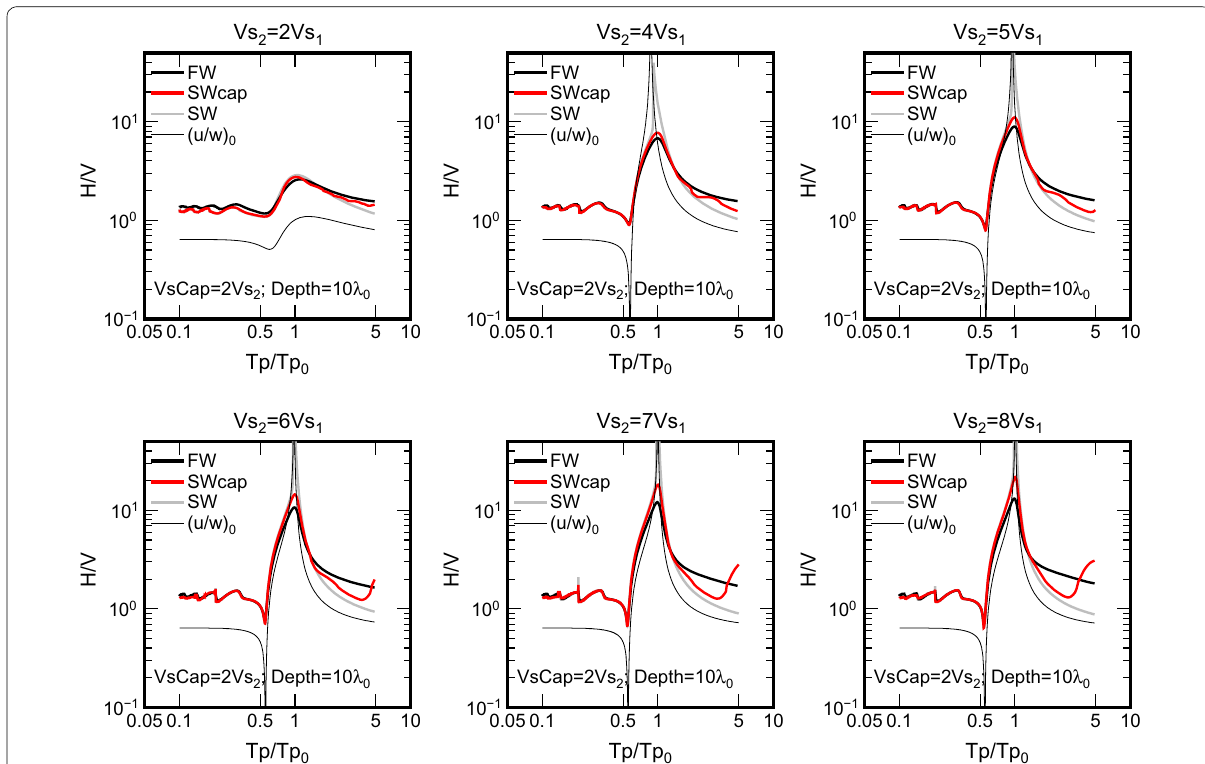
Fig. 3 Comparison between FW H / V s (thick black), SW H / V s (gray), ellipticity of fundamental mode of Rayleigh waves (thin black) of two‑layered media with six different impedance ratios, and SW H / V s (red) of corresponding cap‑layered media (in all cases V sCap the two‑layered media, V s2 2 V s1 in the upper left panel, V s2 = lower left panel, V s2 7 V s1 in the lower middle panel and V s2 =